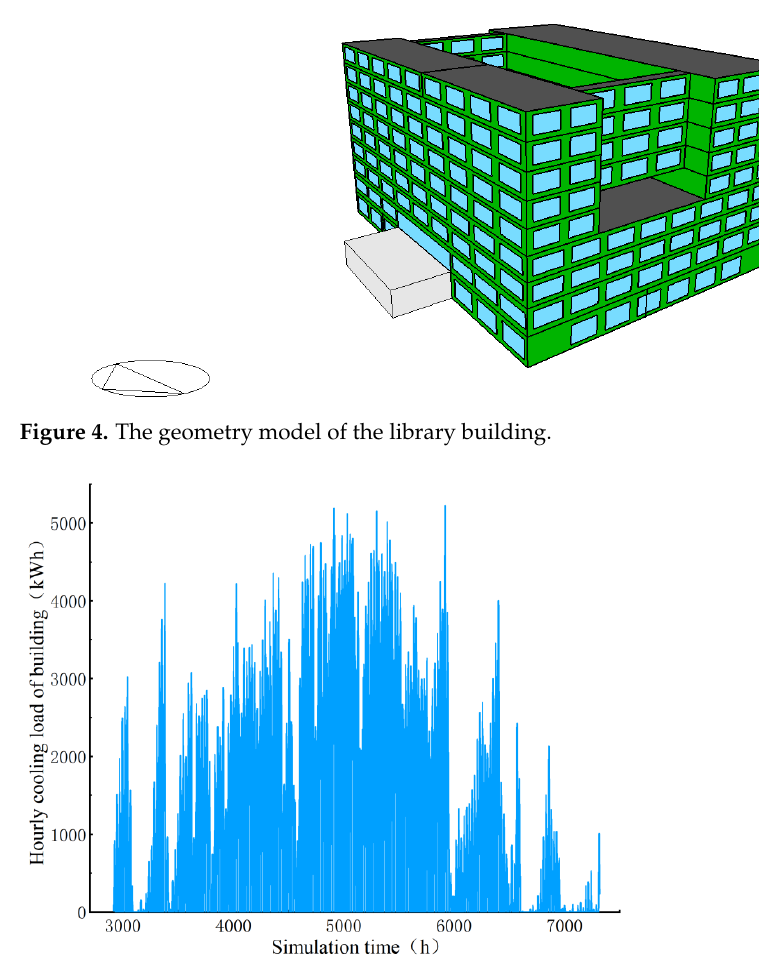
Figure 5. Annual cooling loads of the library building.